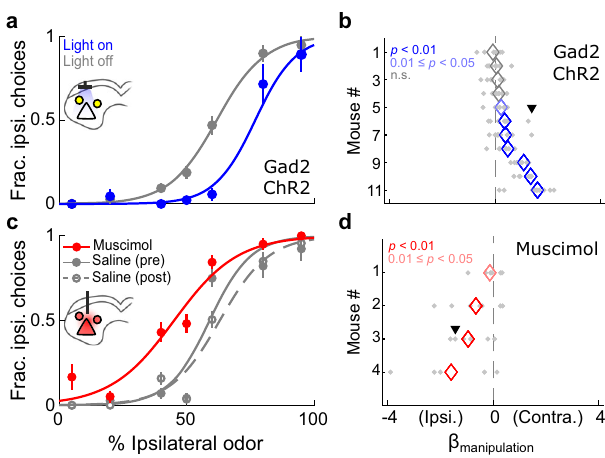
Fig. 2 Photoactivating GABAergic SC neurons during spatial choice promote contralateral choices. a Example session in which GABAergic neurons were unilaterally photoactivated during spatial choice. Here, and in all panels, inset schematic shows the experimental setup. Yellow indicates ChR2-YFP expression. b Overall in fl uence of GABAergic photoactivation on choice ( p = 0.0029, Wilcoxon signed-rank test; n = 7/11 mice, p < 0.05, permutation test), quanti fi ed by logistic regression (Methods). See also Supplementary Fig. 2a for comparison to YFP controls and Supplementary Fig. 3a, c for reaction times. Mice are sorted by effect size. Individual sessions are plotted in light gray. Arrowhead, example session in ( a ). c Example sessions in which muscimol or saline was unilaterally delivered to the SC prior to the behavioral session. d Overall in fl uence of local inhibition on choice in muscimol sessions ( n = 4/4 mice, p < 0.05, permutation test), quanti fi ed by logistic regression. Individual sessions are plotted in light gray. Arrowhead, example sessions in ( c